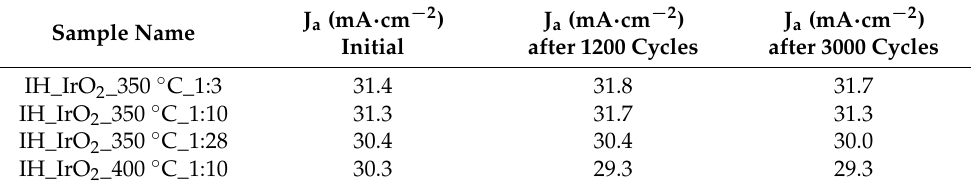
Table 6. Anodic current density measured at 1.6 V vs. RHE during the durability study.